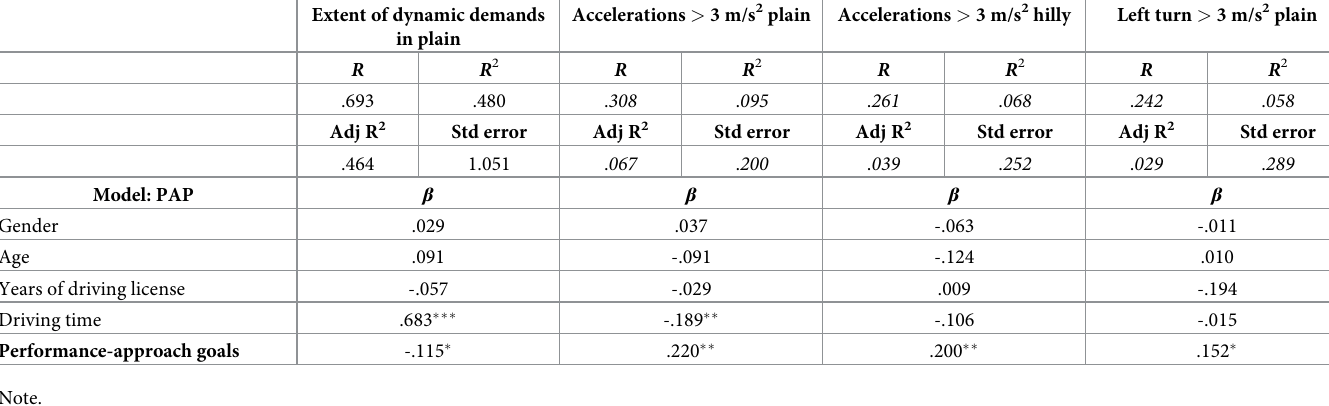
Table 4. Results of the regression analysis for performance-approach goals with the road